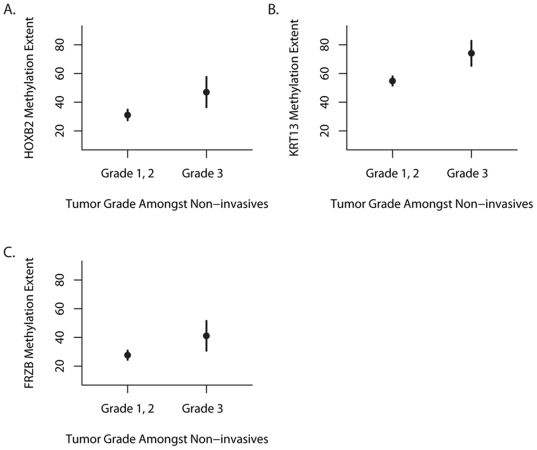
Bisulfite pyrosequencing demonstrates that extent of methylation is associated with tumor grade in non-invasive tumors.The mean (filled circle) and 95% confidence intervals of the extent of methylation of the promoter regions of (A) FRZB, (B) KRT13, and (C) HOXB2 are depicted (y-axis) comparing low (1,2) to high (3+) grade tumors (x-axis). P-values resulting from the Wilcoxon Rank Sums demonstrate that these differences are significant for HOXB2 (P<0.01), KRT13 (P<0.01) and FRZB (P = 0.0001).